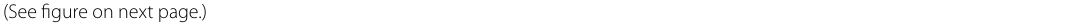
Fig. 2 Enlarged view of the enhanced proton flux and associated plasma parameters. a – d Corrected proton flux measured by GOES at energies ~ 2.5, ~ 6.5, ~ 11.6, and ~ 30.6 MeV. e , f Energetic proton flux measured by SOHO in the 26–32 MeV range and by Wind in the 19–28 MeV range. g – k Various parameters of the solar wind measured by Wind. g Proton number density. h Proton flow speed. i Magnetic field magnitude (| B |). j Magnetic field latitudinal angle ( θ B ). k Magnetic field longitudinal angle ( φ B ). The data are shown in the Geocentric Solar Ecliptic (GSE) coordinate in which X-points toward the Sun, Z parallel to the ecliptic pole, and Y completing the right-hand system